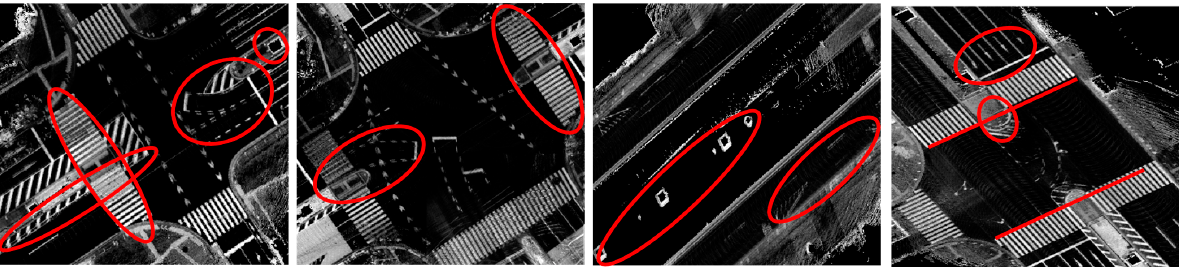
Figure 7. Ghosting (indicated by ellipses) in GIR map of the three segments in Figure 6a. ( a , b ) Rep- resentation of local loop closures in the first collection phase in opposite directions. ( c ) GIR map images with ghosting effects and deviations in landmarks. ( d ) Single scans by the second collection phase. ( e , f ) Map combination: individual merging of images in ( d ) with ( a , b ), respectively.